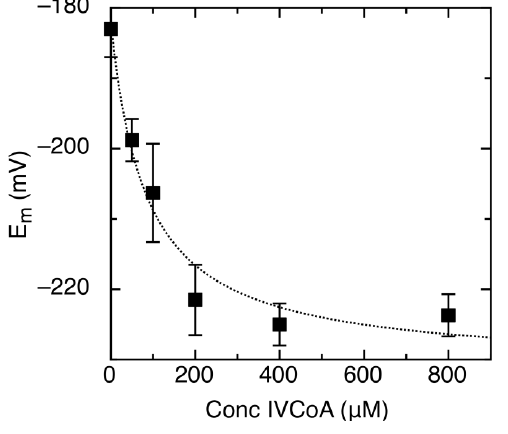
Figure 4. Midpoint reduction potential ( E ) of AidB lowers as a function of isovaleryl-CoA m (IVCoA) concentration. The dotted line is the fit to equation 4 to determine K dapp